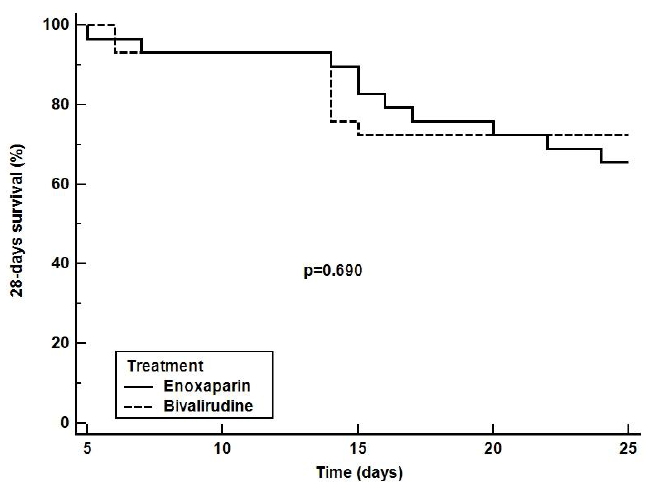
Figure 5. 28-days survival rate. The curves depict the 28-day survival rate from randomization in patients receiving enoxaparin ( solid line ) or bivalirudin ( dashed line ).